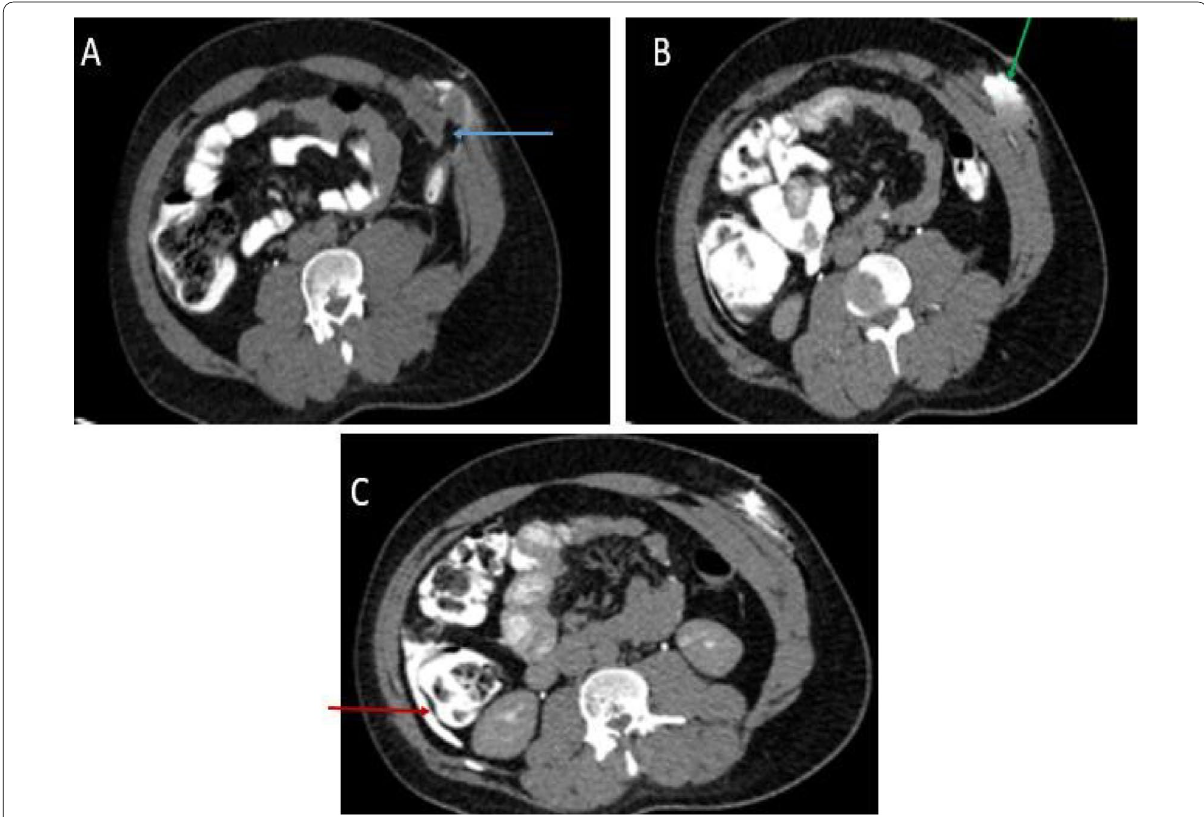
Fig. 3 A 27‑year‑old male patient presented with a stab wound. Contrast‑enhanced MDCT: A Axial image of the site as well as the orientation of the stab wound (blue arrow). B Axial image of CT after enema demonstrates leakage of contrast into the site of the stab wound (green arrow) denoting perforated colon. C Axial image of CT after enema demonstrate leakage of contrast into the site of the stab retroperitoneal space (red